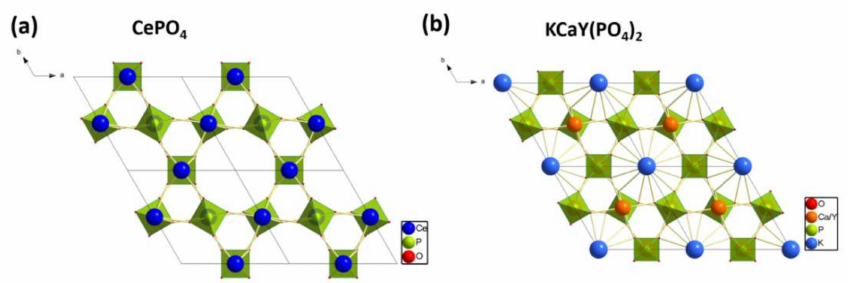
Figure 1. ( a ) A visualization of the rhabdophane type of structure of CePO 4 , and ( b ) of the KCaY(PO 4 ) 2